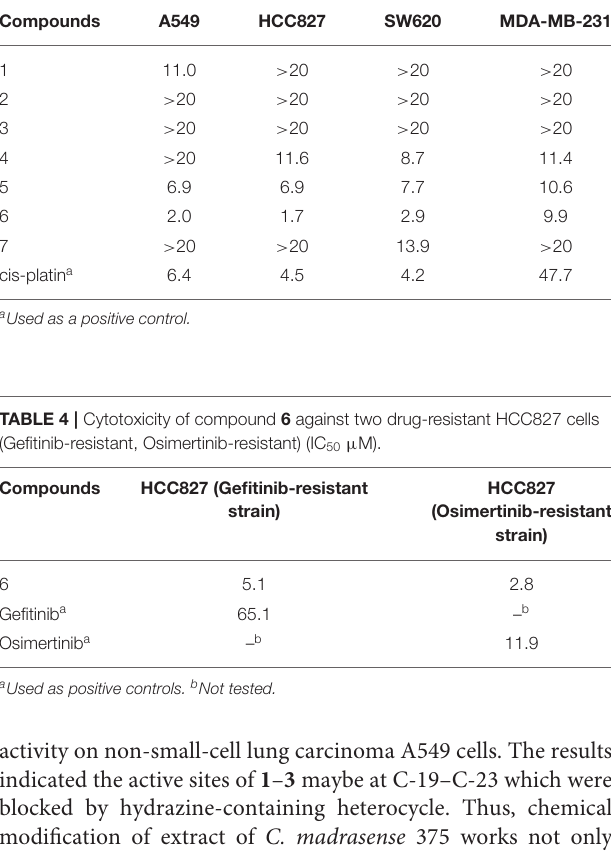
TABLE 3 | Cytotoxicity of compounds 1 – 7 (IC 50 µ M).